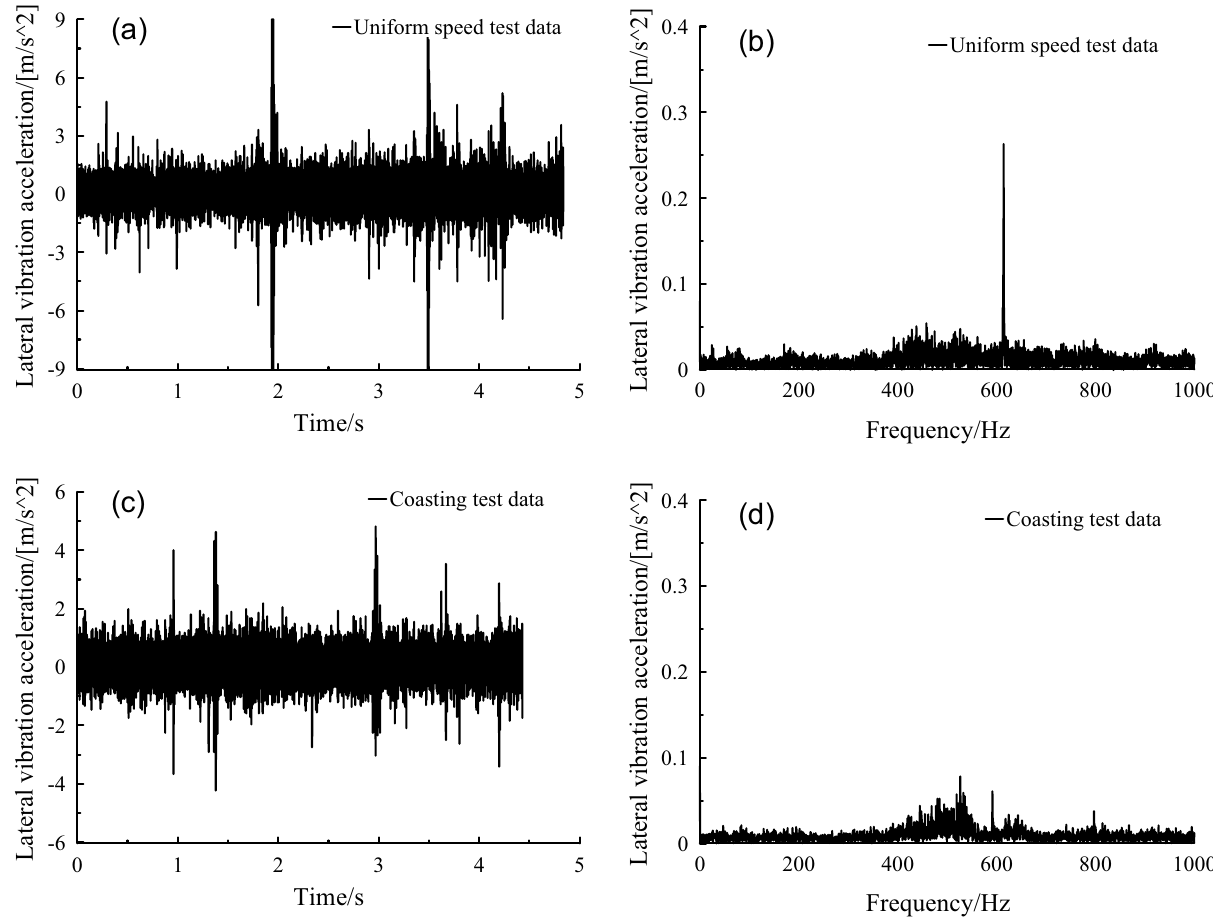
Figure 8. Axle box lateral vibration acceleration, at (a-b) uniform speed, (c-d) coasting